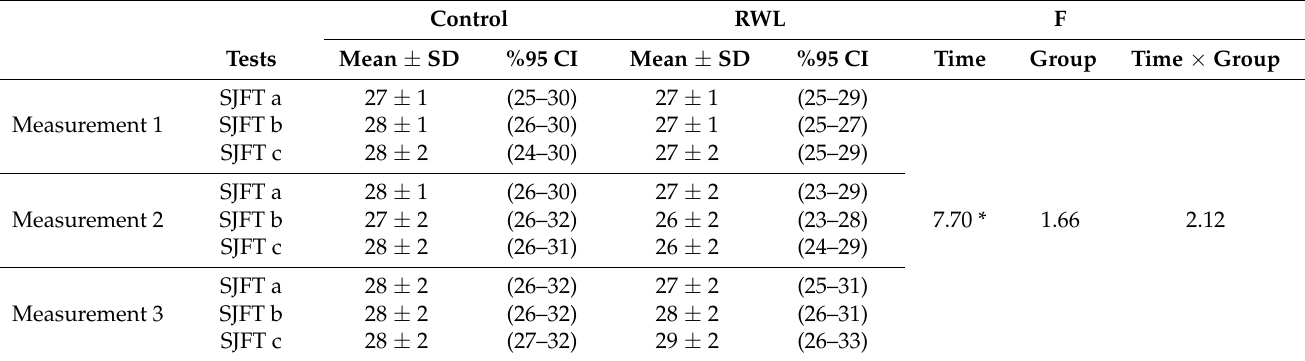
Table 4. Changes in SJFT throw number between control and RWL